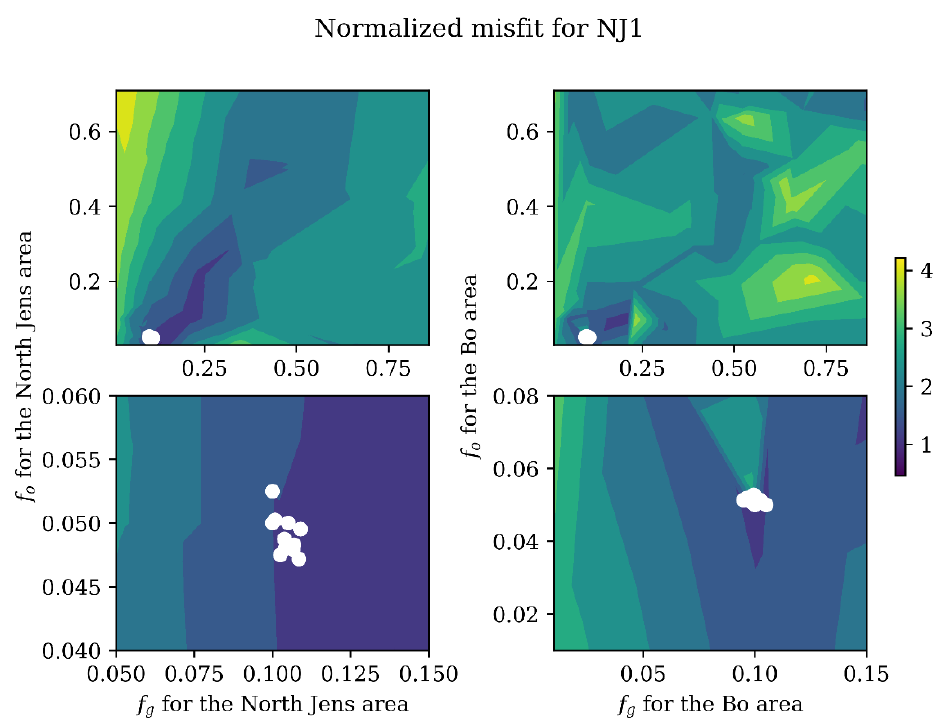
Figure 17. The misfit for the well NJ1 as a function of f g , NJ and f o , NJ ( left graphs) and as a function of f g , Bo and f o , Bo ( right graphs). The iteration steps of the Nelder–Mead simplex algorithm are depicted with white dots. The graphs in the bottom show zooms of the corresponding top graphs. The misfit is normalized to its value at the start of the Nelder–Mead iterations.